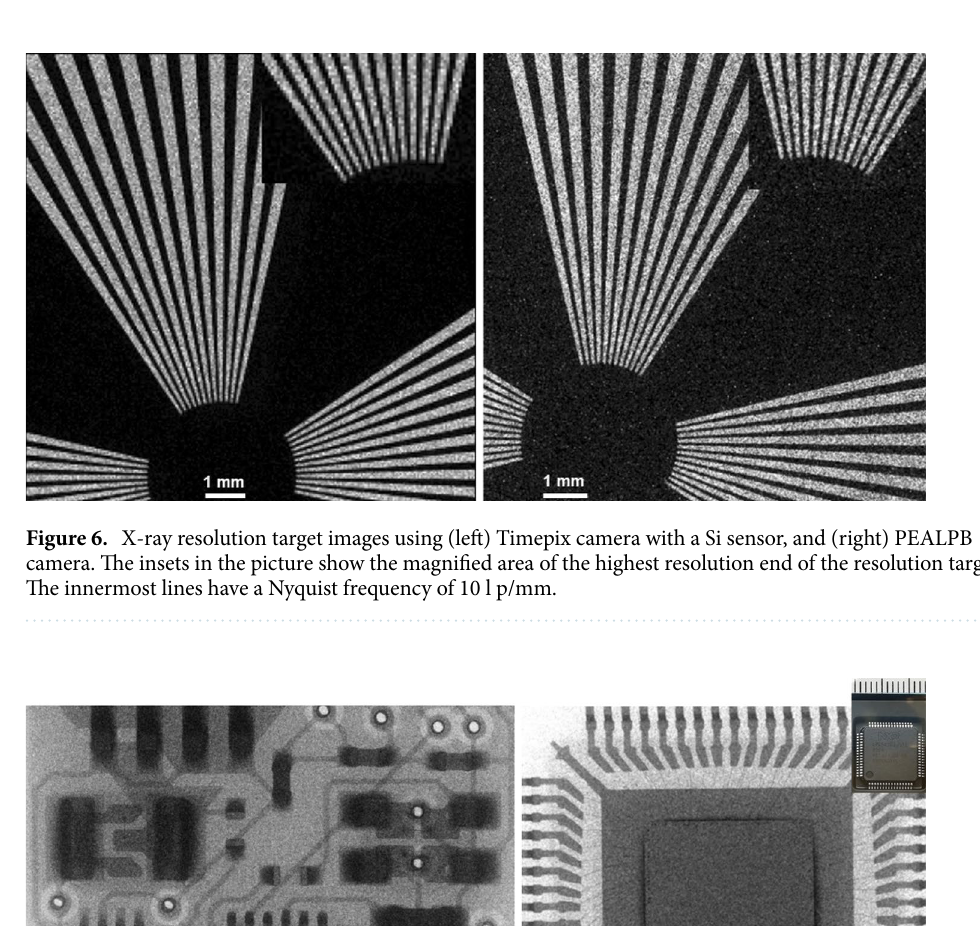
Figure 5. Background X-ray image of the PEALPB camera.